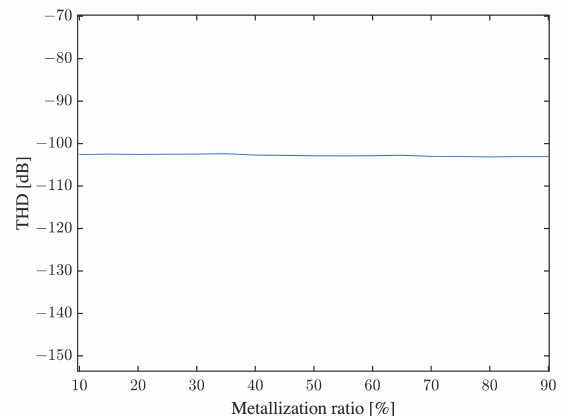
Figure 14. The effect of IDT’s metalization ratio on the device’s THD operating in mode a. THD was calculated by applying Equation (2) to the stabilized portion of the output time series of the simulated device. For example, in Figure 6, outputs between 400 and 900 ns was used. Confirming the linearity of the system, Figure 6b shows a smooth harmonic output exempt of any visible